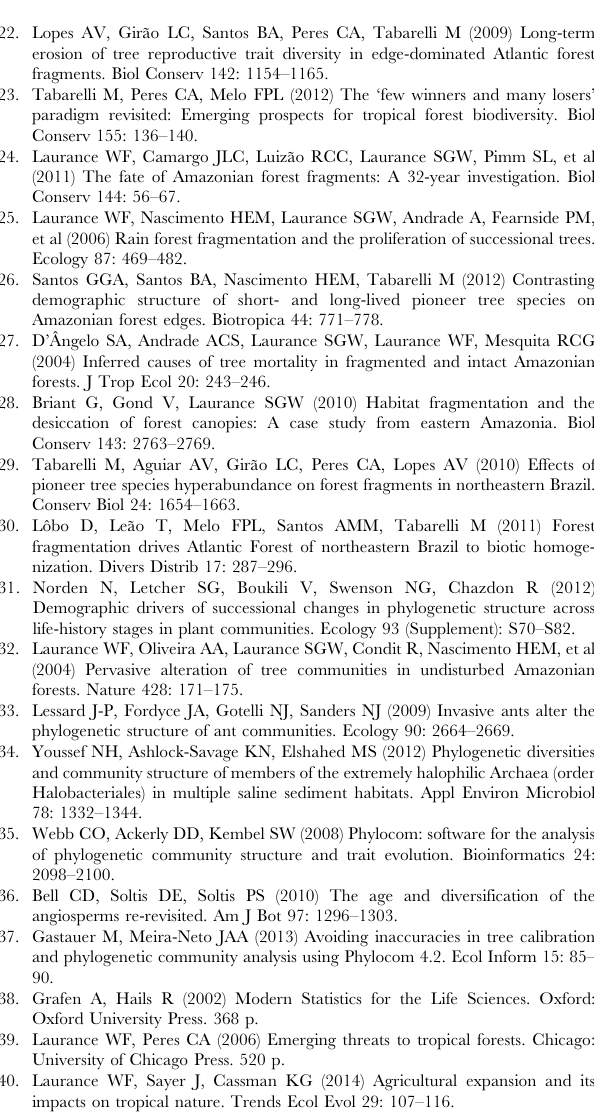
Table S1 Raw data of 40 1-ha tree plots, before and after fragmentation. Table S2 Increasing and decreasing tree genera at the study landscape in Central Amazonia,